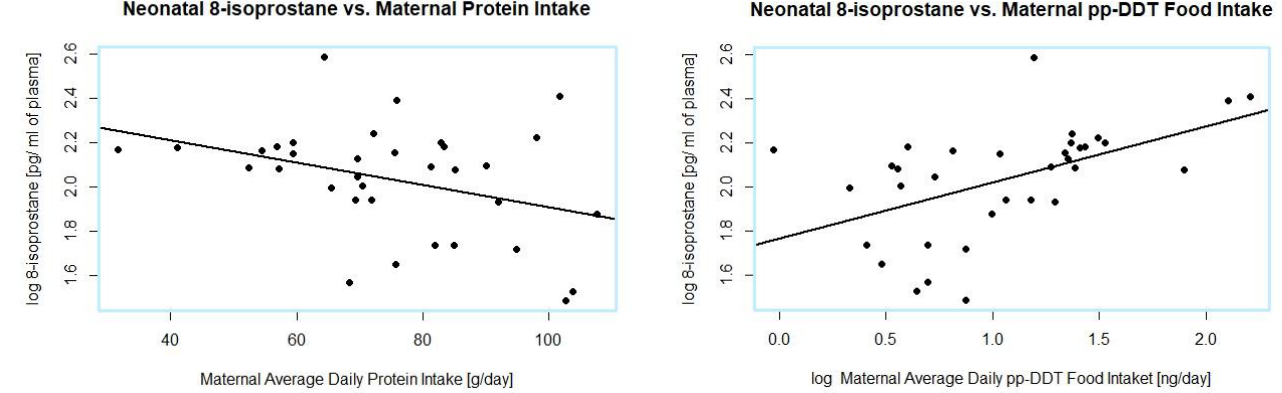
Figure 5. Relationships between neonatal plasma concentrations of 8-isoprostane and maternal food intake of proteins and pp-DDT.